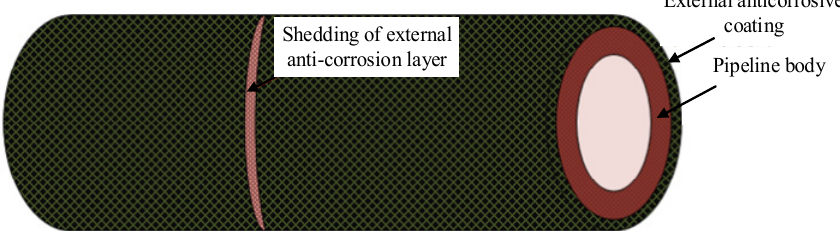
Figure 1. Underwater metal pipeline shedding damage model.